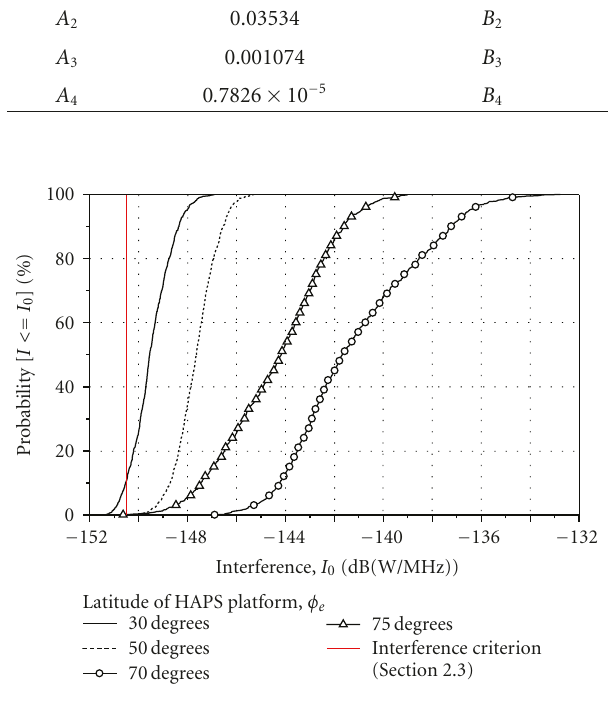
Figure 6: Interference level with the latitude of the HAPS platform φ e .